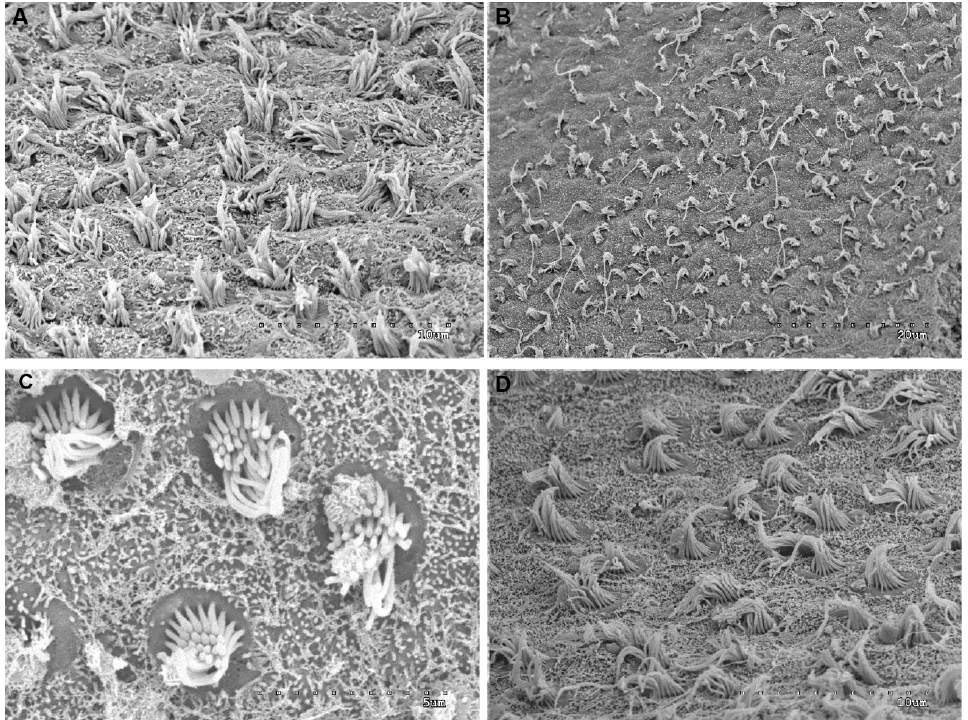
Figure 16. SEM. Salmon inner ear. Saccule sensory epithelium. ( A ) Control. ( B ) 3 weeks after sound exposure. ( C ) 6 weeks after sound exposure. ( D ) 12 weeks after sound exposure. By comparison with control animals, the images of the saccule epithelium show healthy sensory hair cells in all cases of exposed animals. Scale bar: ( B ) = 20 µm. ( A , D ) = 10 µm. ( C ) = 5 µm.